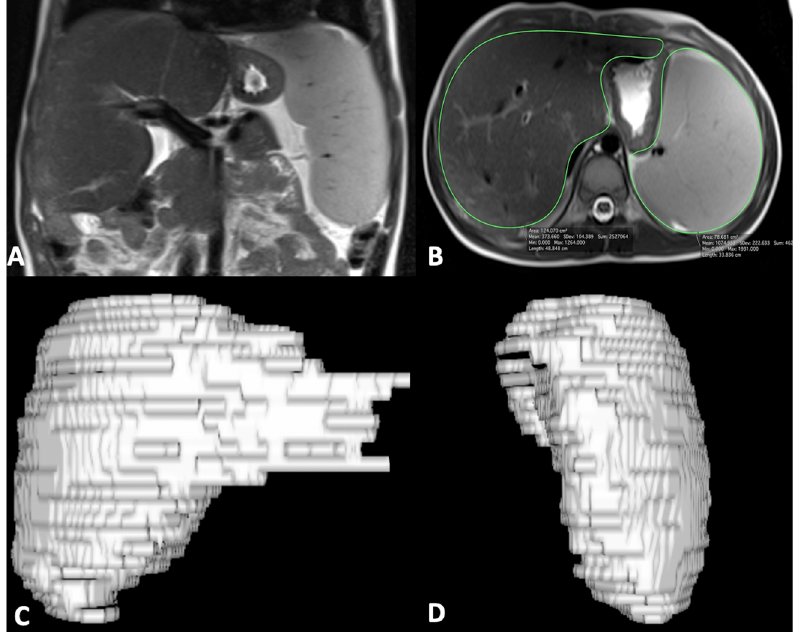
Figure 1. Coronal MR image shows liver and spleen enlargement ( A ); axial MR image shows ROI analysis of liver and spleen ( B ) to obtain 3D liver ( C ) and spleen ( D ) volume reconstruction images; of note, ROI analysis was performed on multiple sequential slices for completely including the liver and